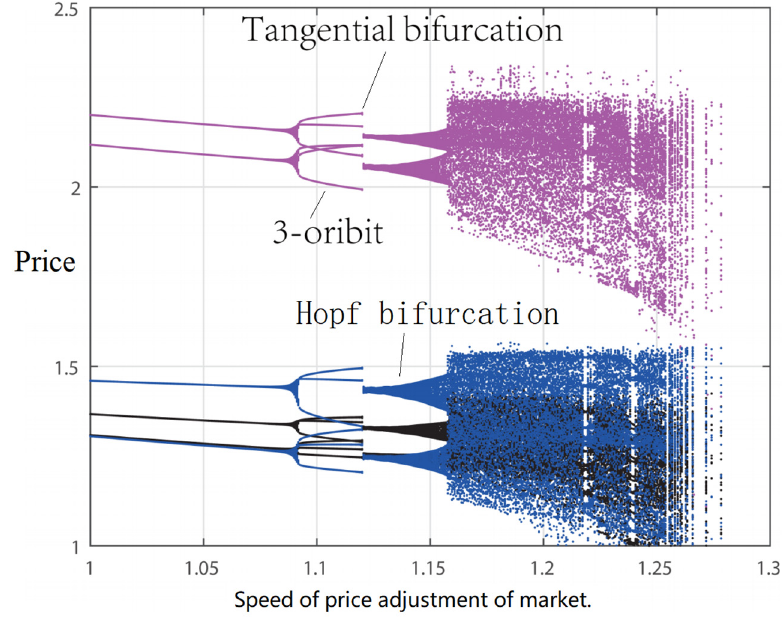
Figure 13. Three-period bifurcation and tangential bifurcation [11].